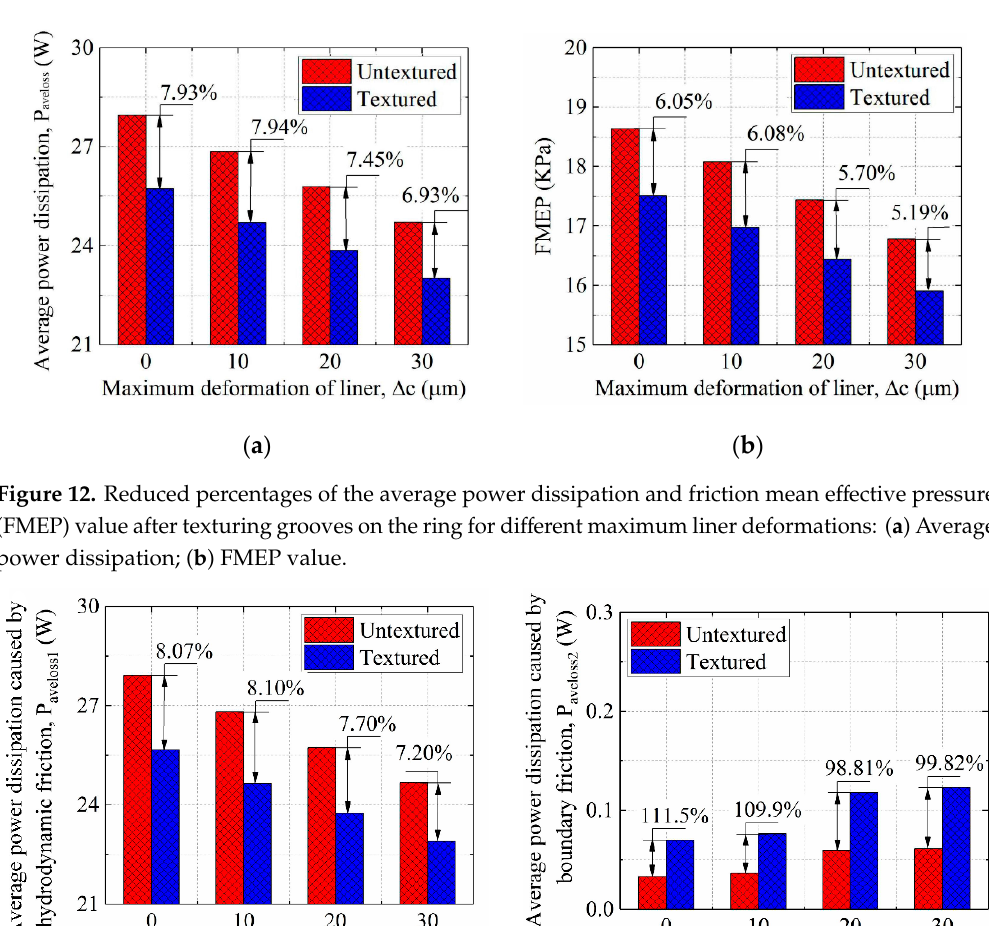
( d ) Figure 11. Boundary friction forces in the textured RLC and untextured RLC: ( a ) Δ c is 0 μ m; ( b ) Δ c is 10 μ m; ( c ) Δ c is 20 μ m; and ( d ) Δ c is 30 μ m. Table 3. Reduction percentages of the hydrodynamic friction force at the middle of strokes for different maximum liner deformations. Maximum Deformation of Liner, Δ c